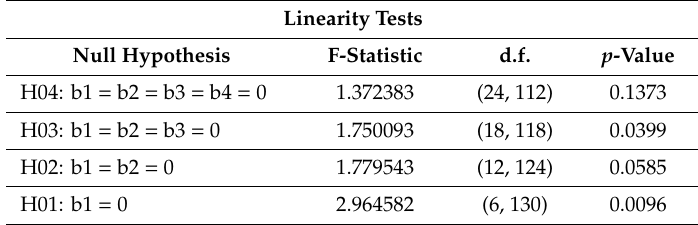
Table 6. Linearity test